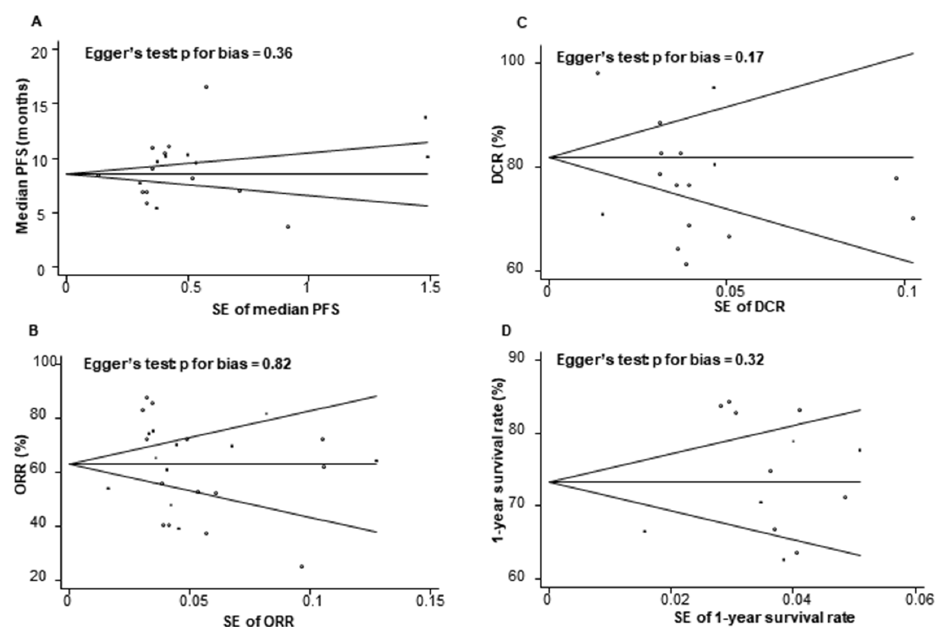
Figure 2. Begg’s funnel plots and Egger’s test for publication bias by different outcomes. ( A ): PFS, progression-free survival, ( B ) ORR, overall response rate, ( C ) DCR, disease control rate, ( D ) 1-year survival rate; SE, standard error.